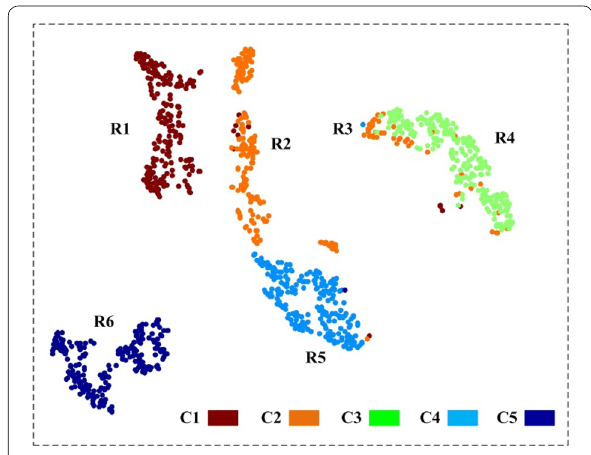
Figure 9 The scatter plot of the classification results ( k